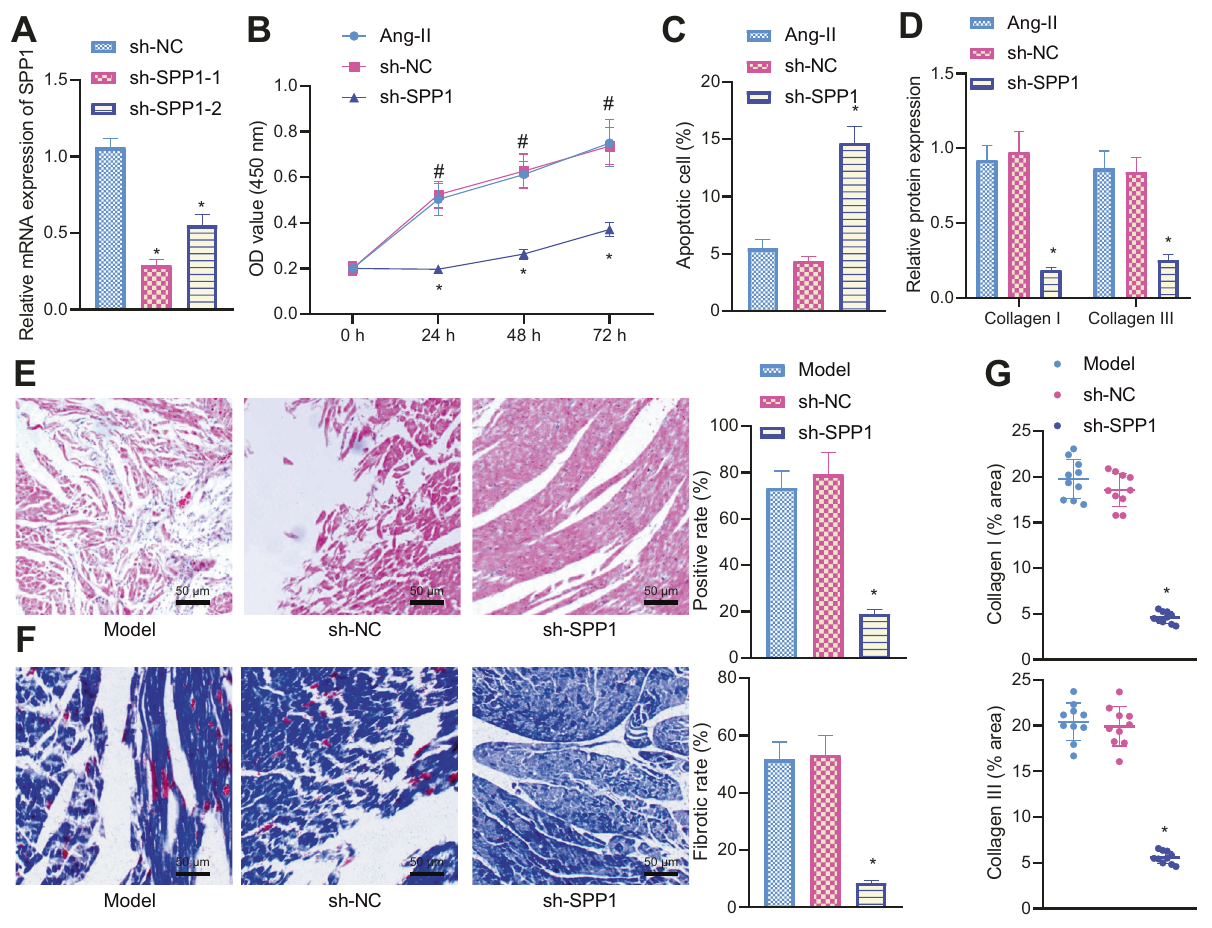
Fig. 2 SPP1 silencing delays atrial fi brosis. A RT-qPCR detection of SPP1 expression in HL-1 cells treated with sh-SPP1-1 or sh-SPP1-2. B CCK- 8 detection of cell viability in HL-1 cells treated with sh-SPP1. C TUNEL detection of apoptosis of HL-1 cells treated with sh-SPP1. D Western blot analysis of collagen I and collagen III proteins in HL-1 cells treated with sh-SPP1. E HE staining of pathological changes of atrial tissues of mice treated with sh-SPP1. F Masson ’ s trichrome staining of atrial fi brosis degree in mice treated with sh-SPP1. G IHC analysis of collagen I and collagen III proteins in atrial tissues of mice treated with sh-SPP1. * p < 0.05, compared with the Ang II-induced HL-1 cells or mice treated with sh-NC. All experiments were repeated three times independently. n = 10 for mice in each